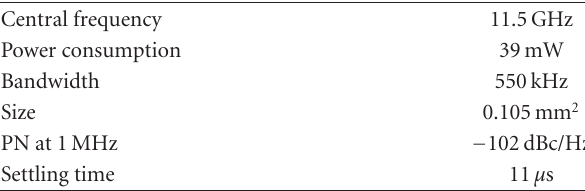
Table 3: Simulated PLL characteristics.